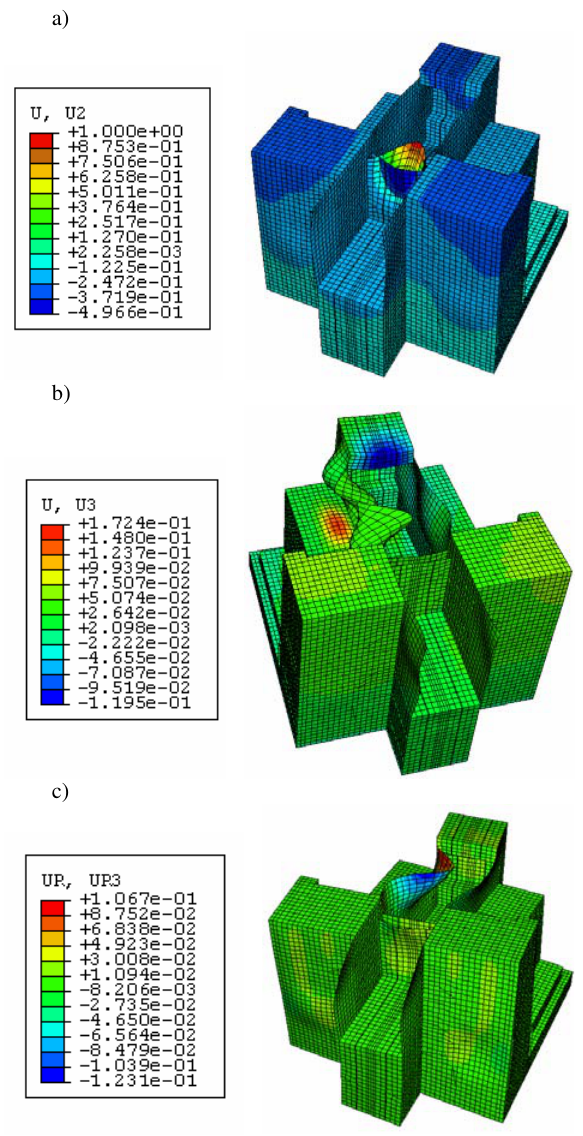
Fig. 8. Typical vibration modes: a – East-West direction dominated bending mode; b – axial dominated mode; c – torsion dominated mode